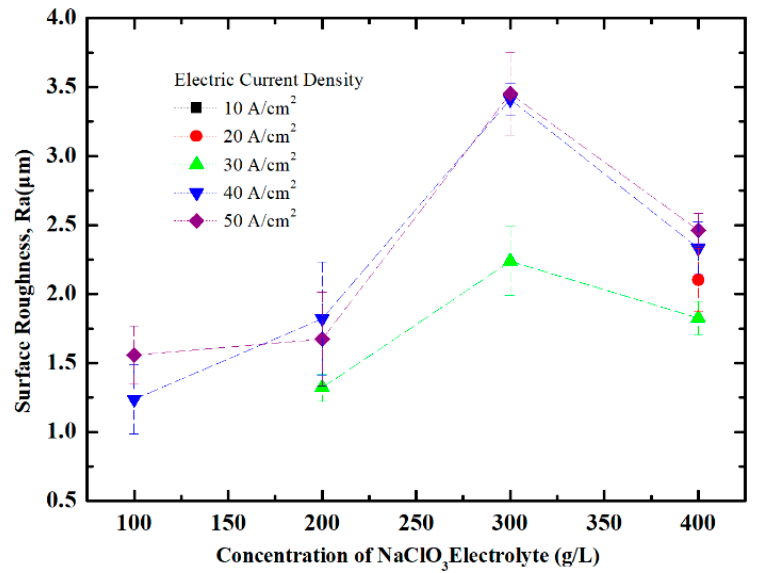
Figure 9. Surface roughness of workpiece at different concentration in NaClO 3 electrolyte.